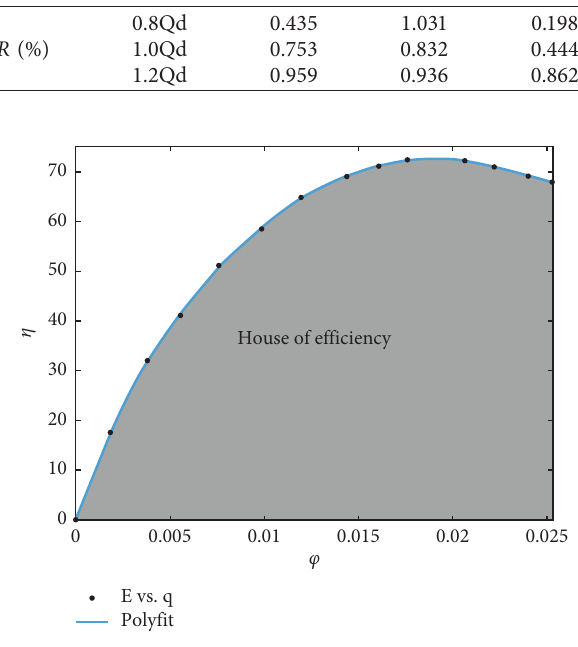
Figure 10: Sketch map of “efficiency-house” model.